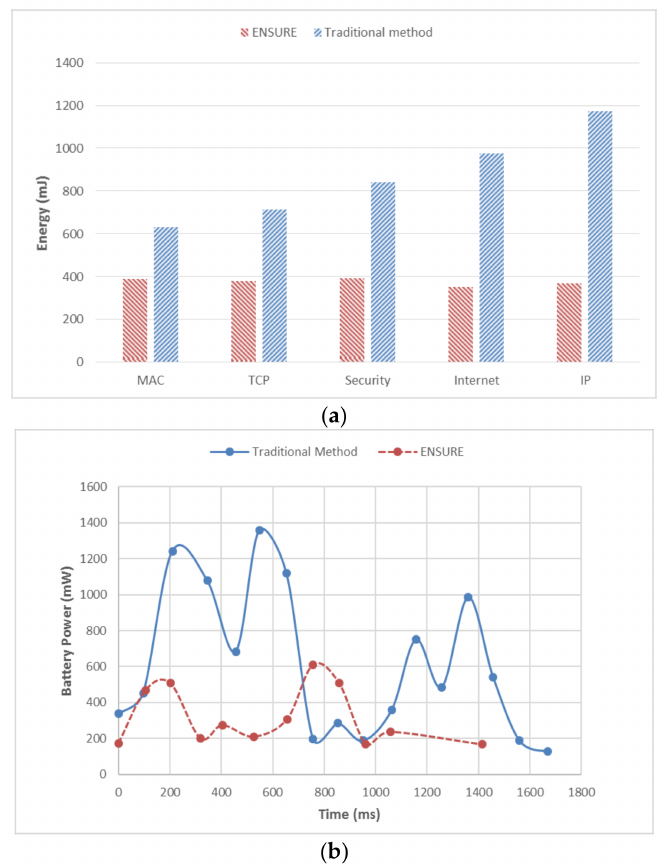
Figure 5. Performance of Energy Consumption. ( a ) Energy consumption of ENSURE and Traditional Method; ( b ) power versus time while searching keyword